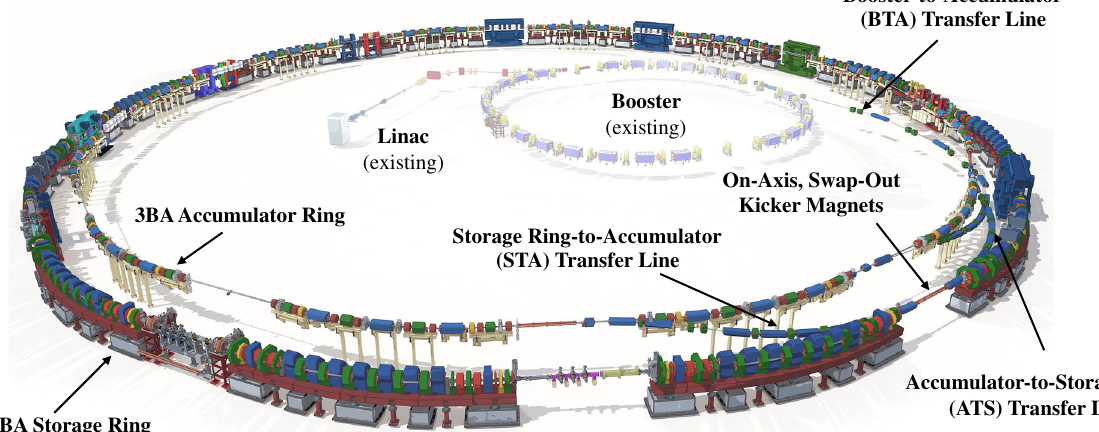
FIG. 3. View of the Advanced Light Source Upgrade (ALS-U) complex. Every 1.4s up to four bunches are generated and accelerated to 2 GeV through the existing linac and booster ring and then injected through the BTA into the new accumulator ring (AR) to top-off a single 25- (or 26-) bunch train. Every ∼ 30 s this train trades place (swap-out) with one of the eleven trains circulating in the storage ring (SR). On-axis injection/extraction swap-out is enabled by a fast kicker located in the straight section of SR Sector 1 (across from the landing point of the BTA in the straight section of AR Sector 1).